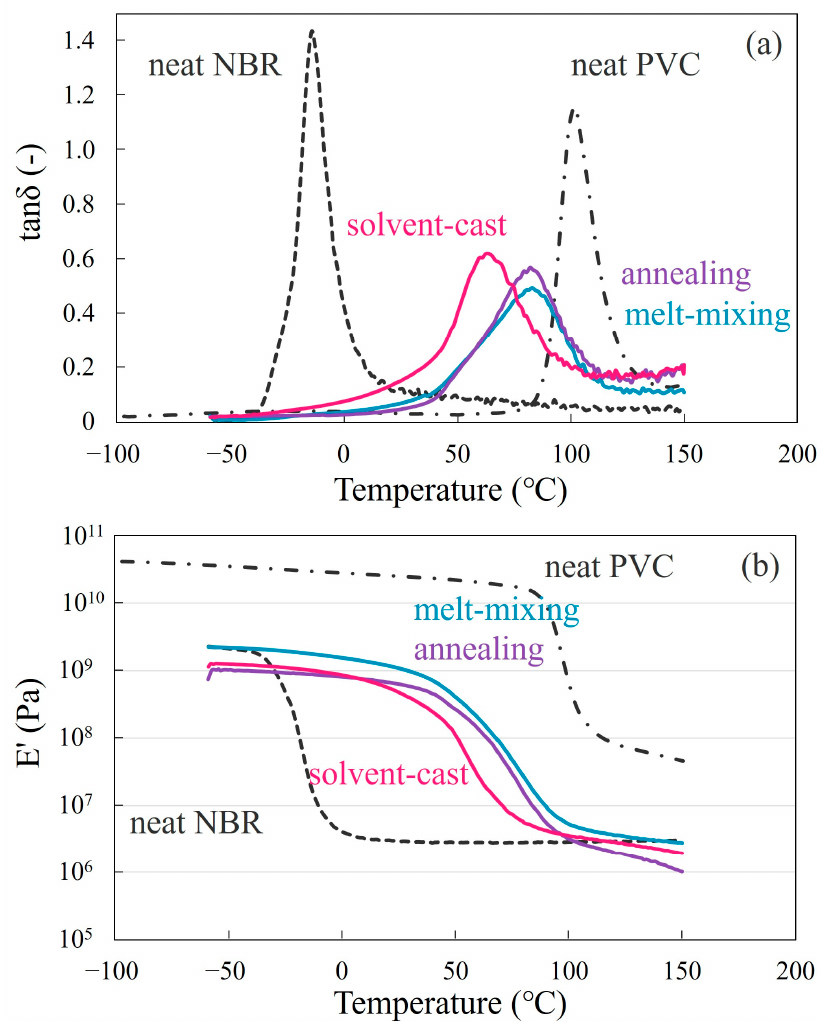
Figure 5. Dynamic mechanical analysis thermograms at a heating rate of 5 °C/min for 20/80 NBR/PVC obtained by solvent-cast, annealing at 150 °C after solvent-cast, and melt-mixing at 150 °C: ( a ) tan δ ; ( b ) storage modulus E ′ .